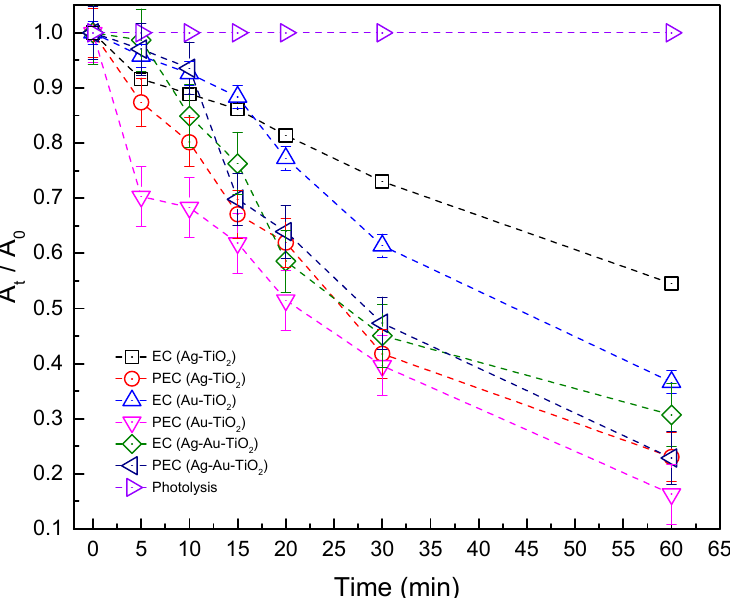
Figure 10. Comparison of color removal of malachite green dye solution at pH = 1 by the photoanodes in the EC and PEC tests.